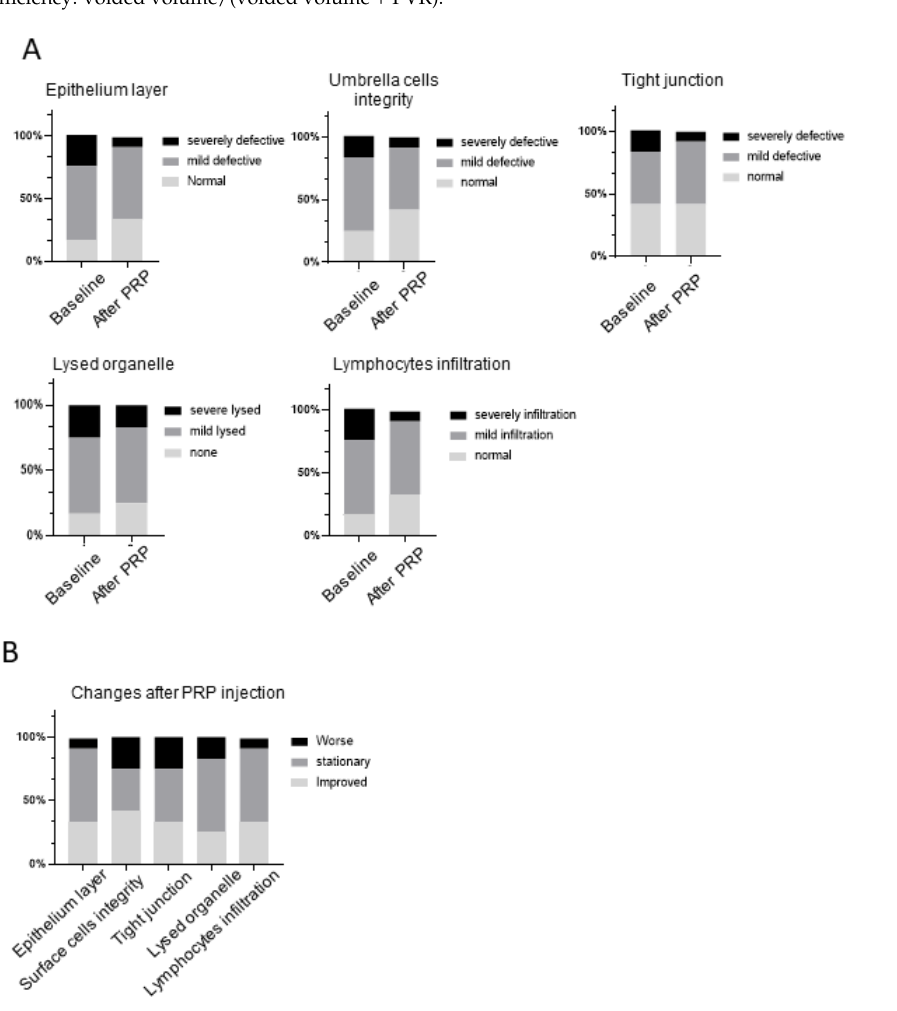
Figure 3. EM evidence revealed IBCs in the human rUTI bladder biopsy specimens. ( A , B ) IBCs were detected in the uroepithelial cells in the patients with rUTI who had recovered from an acute UTI episode, suggesting that bacterial incubation leads to UTI recurrence in patients.